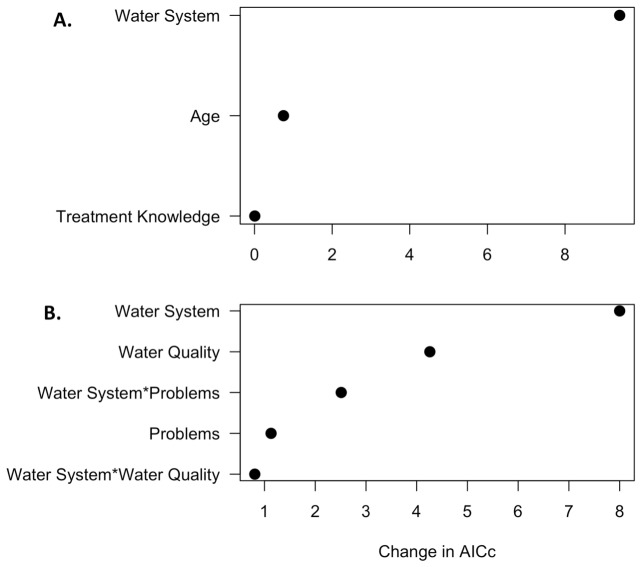
Importance of Each Covariate for Model Fit in the Two Models that Predict Household Water Management Strategies.Change in AICc for each of the covariates considered in the full logit model for the number of drinking water sources (A) and whether households treat or do not treat water (B). Larger changes in AICc values suggest that the variable contributed more to overall model fit. In both analyses (A and B), the institutional variable Water System (i.e. PRASA, non-PRASA) is the variable that contributes most to overall model fit. In the analysis of whether households treat water (B), water quality perceptions were also an important variable.